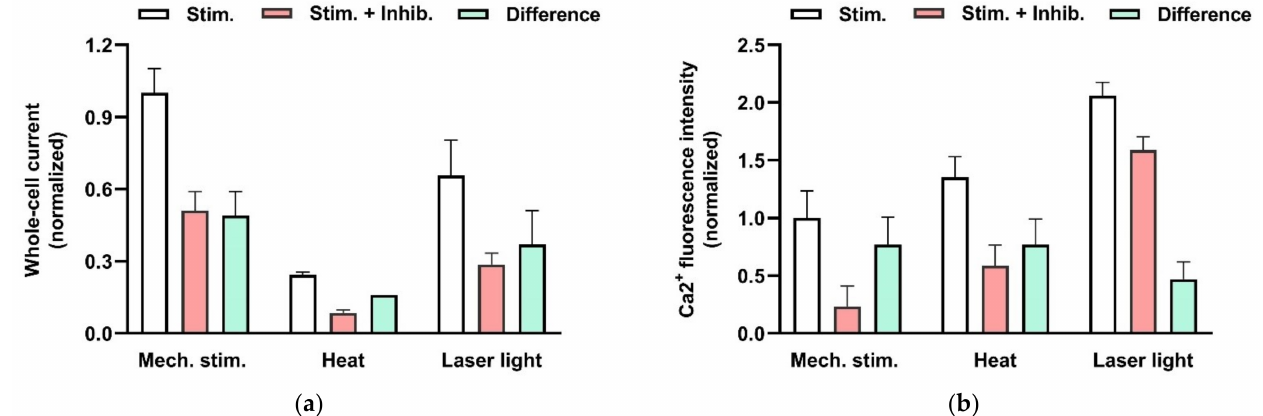
Figure 7. Effects of physical stimulation of HMC-1 on whole-cell patch-clamp current ( a ) and intracellular Ca 2+ activity ( b ) mediated by TRPV2 channels. ( a ) Currents were recorded at − 100 mV and activated by mechanical stress ( − 60 cm H 2 O) applied to the patch pipette, by heat (exposure to solution preheated to 53 ◦ C), or by red laser light (at 640 nm and 48 mW). The columns represent the current in the absence (not filled) and the presence (red) of an TRPV inhibitor (20 µ M SKF96365 or 10 µ M Ruthenium red). In addition, the inhibitor-sensitive, TRPV2-mediated components (difference) are shown (green). The data are normalized to the current signal that can be induced by physical stimuli. The signal changes are significant based on p < 0.05. Data are extracted from Zhang et al. (2012) [38]. ( b ) Increase in intracellular Ca 2+ fluorescence intensity was measure in HMC-1 cells loaded with 4 µ M “Calcium Green-1AM”. TRPV2 is activated by mechanical stress (hypotonic solution (240 mOsm compared with 310 mOsm) applied to the cell suspension), by heat (exposure to solution preheated to 53 ◦ C), or by red laser light (at 640 nm and 48 mW). The columns represent the intensities in the absence (not filled) and the presence (red) of an TRPV4 inhibitor (20 µ M SKF96365). The TRPV2-mediated Ca 2+ increase is considered to the difference (green). The data are normalized to the fluorescence signal that can be induced mechanically. The signal changes are significant based on p < 0.01, and on data from Zhang et al. (2012)